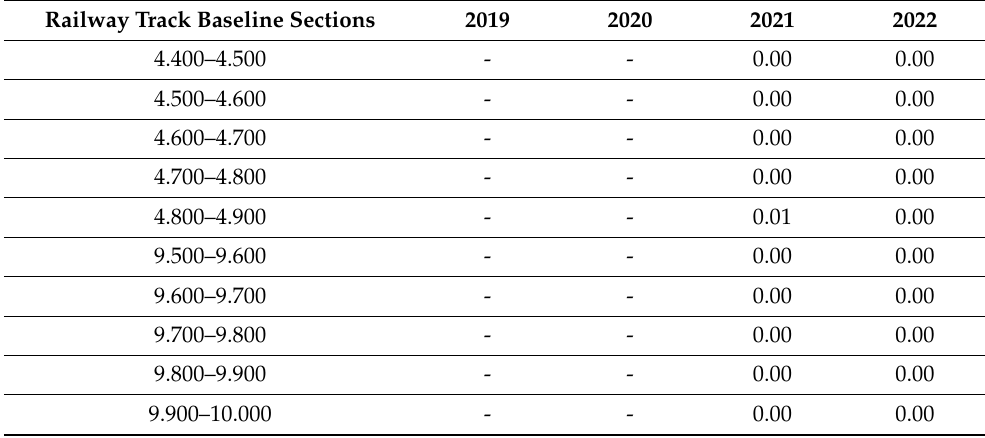
Table A15. Estimates of the railway track condition—relative D 6 , object No. R 161_2. Railway Track Baseline